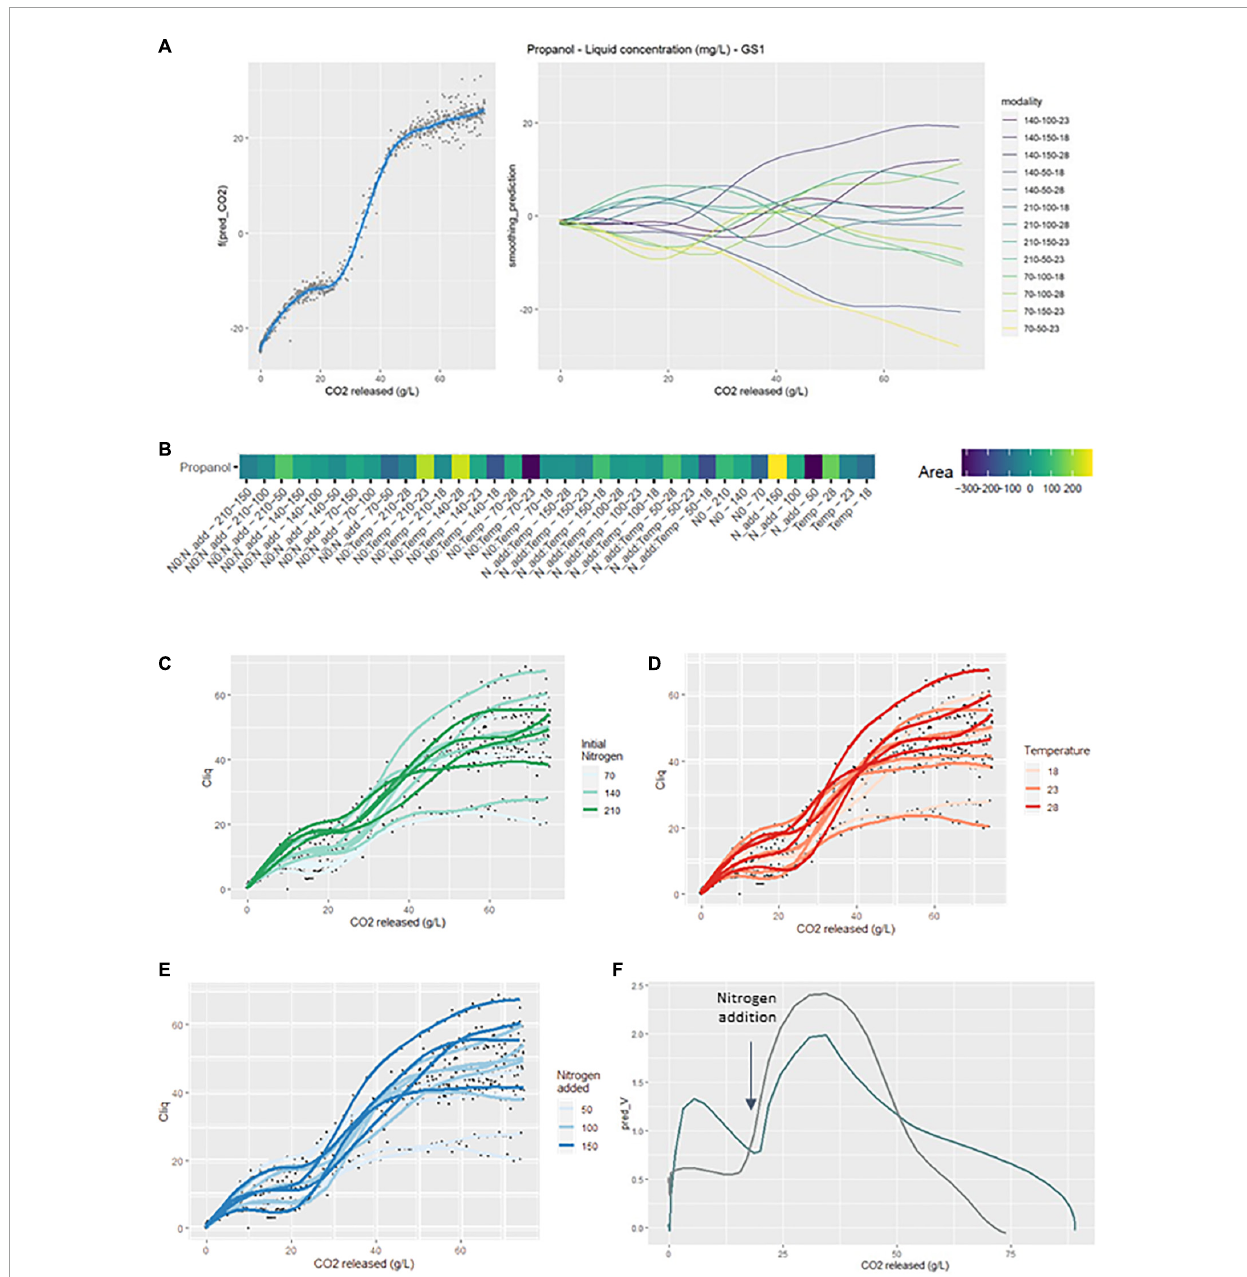
FIGURE5 GAM modeling of propanol production kinetics. (A) Left: Smoothing average of the propanol concentration, right: Deviations of each modality from this average smoothing. (B) Heatmap representing magnitudes of each factor and every possible interaction using areas under the curves of the deviations from the average smoothing. (C–E) Prediction curves for each modality represented with a color depending on the level of NO, temperature and Nadd. (F) Rate of released CO 2 (dark blue) and rate of total propanol production (gray) vs. the CO 2